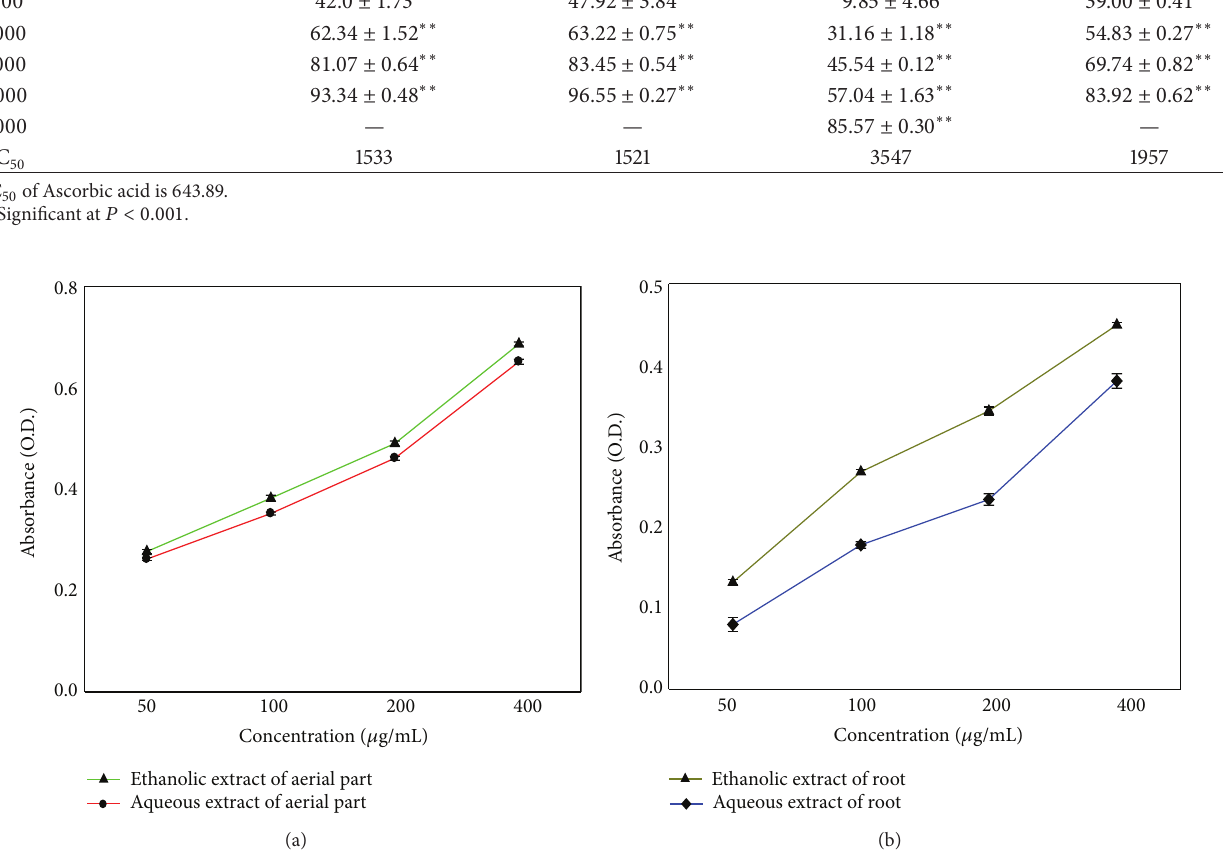
Figure 1: Reducing power of extracts of P. fraternus . (a) Ethanolic and aqueous extracts of aerial part. (b) Ethanolic and aqueous extracts of root. Results are mean ± SE of three independent